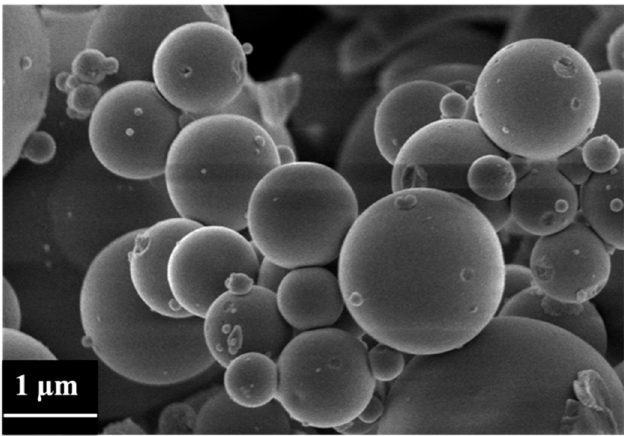
Figure 7. FE-SEM image of MBG_Sr_NAC.